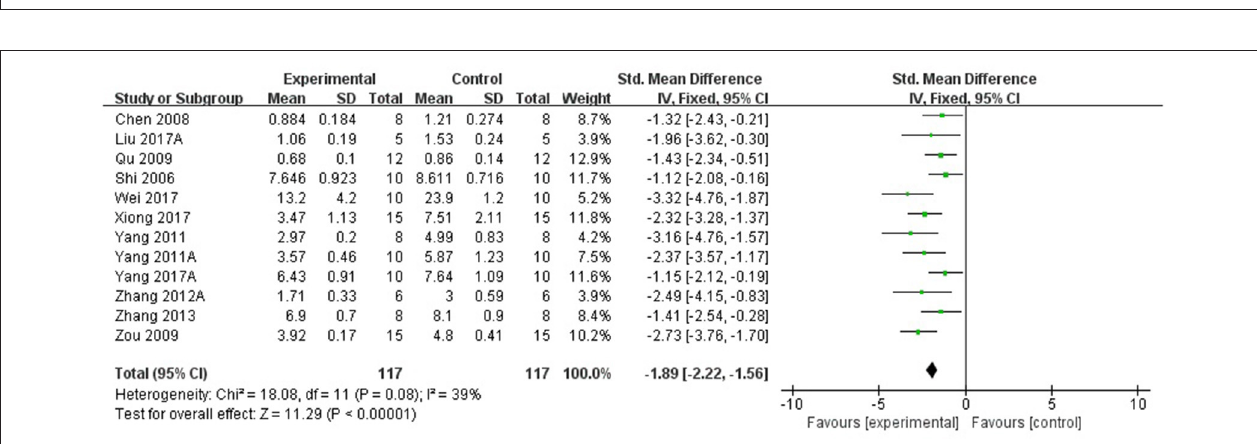
FIGURE 7 | The forest plot: effects of Rhodiola rosea L. for decreasing malondialdehyde compared with control group.